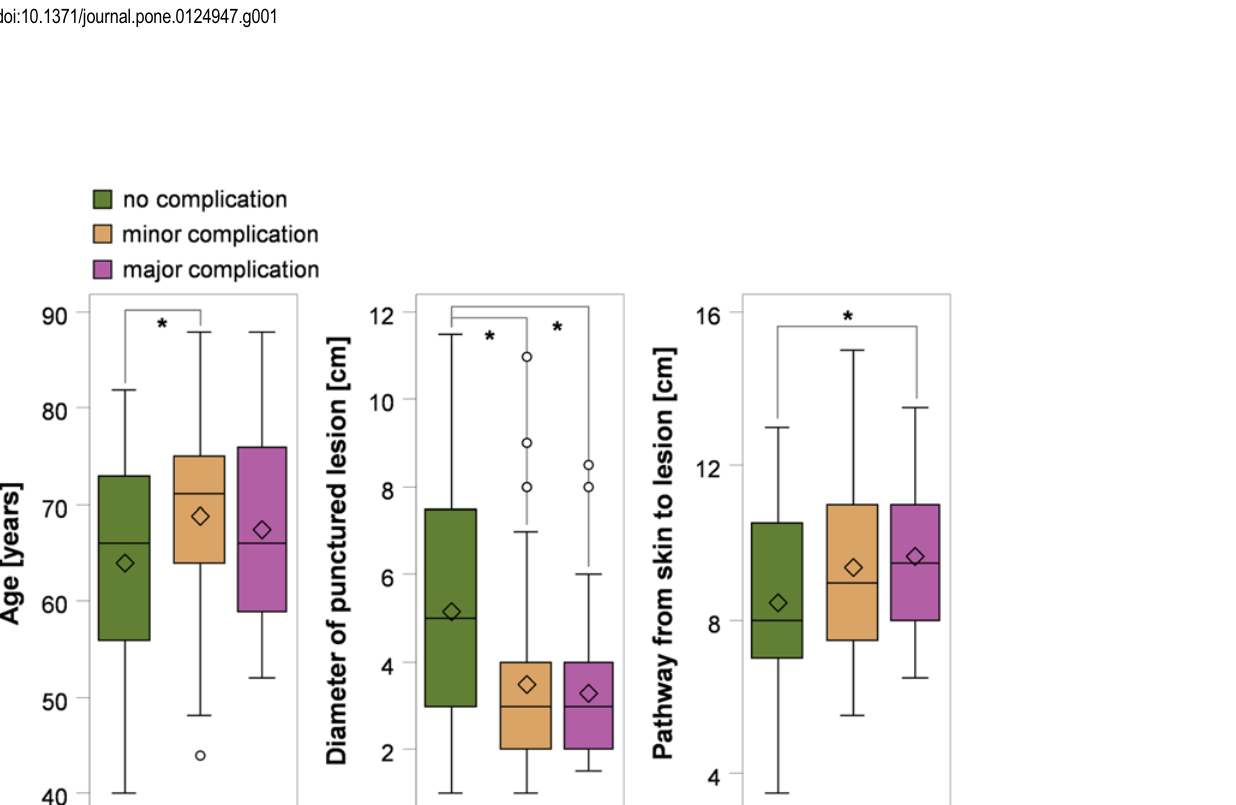
PLOS ONE | DOI:10.1371/journal.pone.0124947 April 9, 2015 5 /